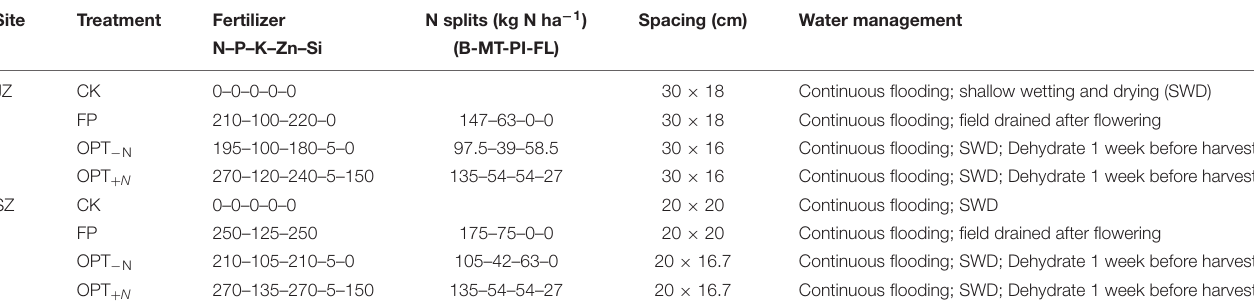
TABLE 1 | Treatments imposed in 2017, 2018, 2019, and 2020 at the sites of Jingzhou and